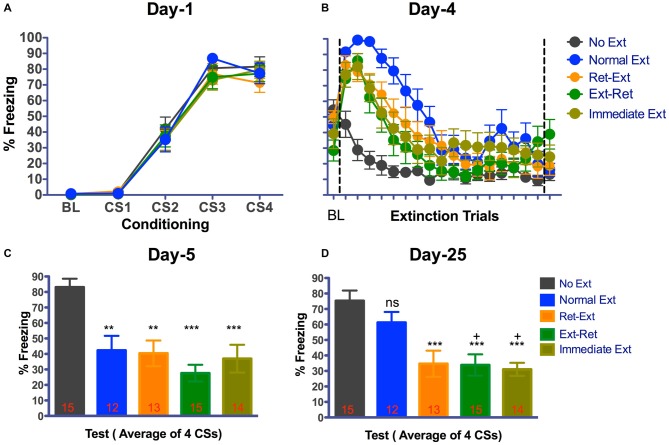
Attenuation of fear memory after various extinction procedures. Graphs show fear and extinction learning curves (A,B) and extinction memory during a memory test carried out 1 and 21 day(s) after the end of each extinction procedure in context B (C,D). Mean ± SEM freezing during Baseline (BL) and tone for all rats were measured. (A) Fear acquisition. Rats were fear conditioned with 4 tone-shock pairings on Day-1 in context A. All animals acquired cue fear. (B) Fear retrieval and extinction. Rats received retrieval and extinction procedures in context B on Day-4. Immediate extinction group was fear conditioned in Context A with four tone-shock pairings and 10 min later they received normal fear extinction session in context B. Each data point for extinction trials represent the average of 3 CSs except the 17th data point that represents average of 2 CSs totaling 53 CSs. Data point after the line break represent the average of 3 retrieval CSs for Ret-Ext and Ext-Ret groups. All rats showed significant within session extinction learning on Day-4. (C) Fear extinction memory test. As a measure of extinction memory, rats received 4 tone presentations in context B on Day-5. (D) Spontaneous recovery test. Rats received four tone presentations in context B on Day-26. Normal Ext group showed freezing similar to No Ext group suggesting significant spontaneous recovery of fear. Ret-Ext, Ext-Ret and Immediate Ext groups showed no spontaneous recovery of fear. One-Way ANOVA with Tukey’s multiple comparison test was used for Days-5 and 26. (ns, not significant; **P < 0.01; ***P < 0.001 vs. No Extinction (C,D). +P < 0.05 vs. Normal Extinction (D). Groups: No Ext, no extinction; Normal Ext, normal extinction; Ret Ext, retrieval first + extinction; Ext—Ret, extinction + retrieval later; Immediate Ext, Fear conditioning first + immediate extinction. Rats were tested repeatedly on Day-5 and Day-26.